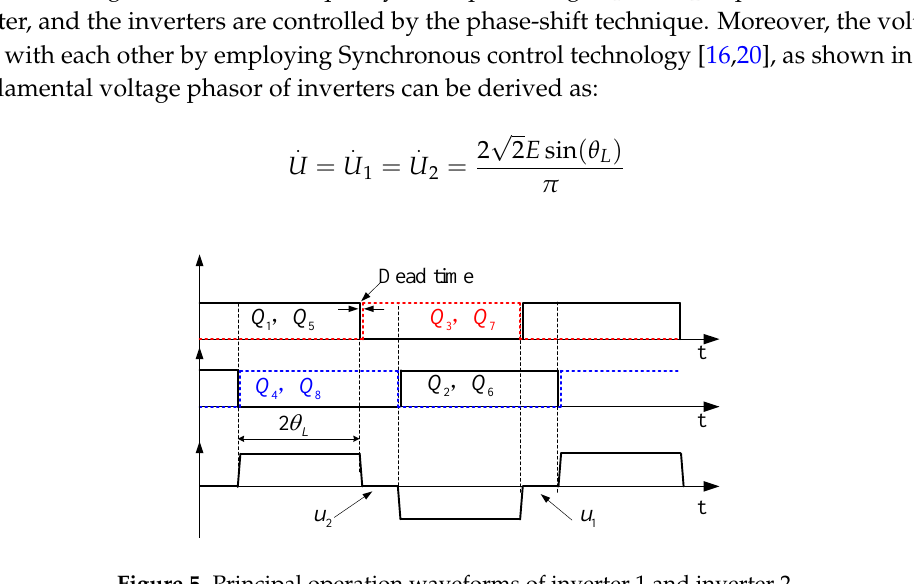
Figure 5. Principal operation waveforms of inverter 1 and inverter 2.